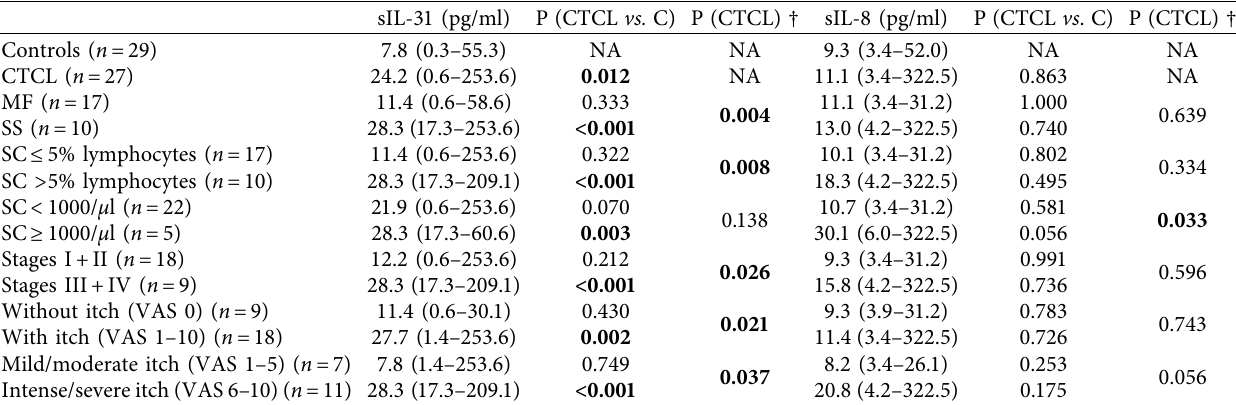
Table 3: IL-31 and IL-8 serum levels in patients with CTCL and healthy controls.